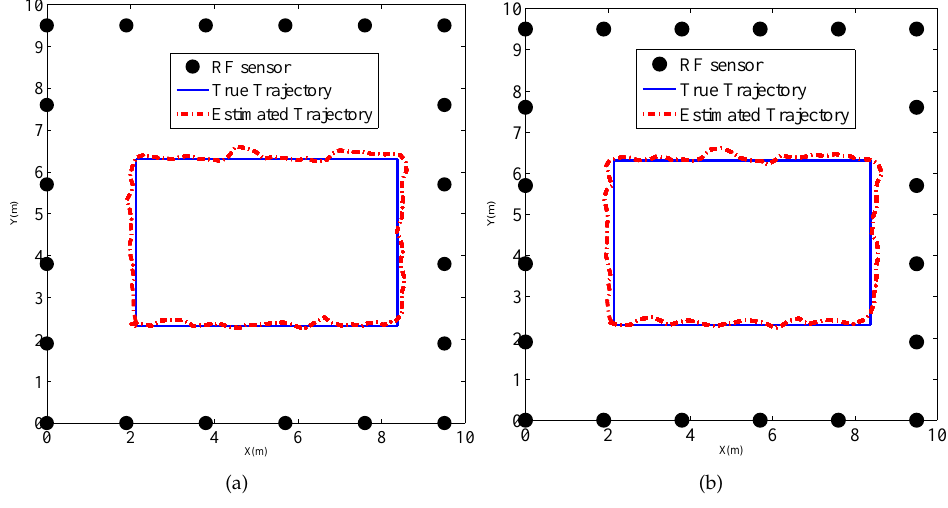
Figure 12. Tracking result of ( a ) traditional mode using raw measurements; and ( b ) binary mode using link states in the outdoor environment.